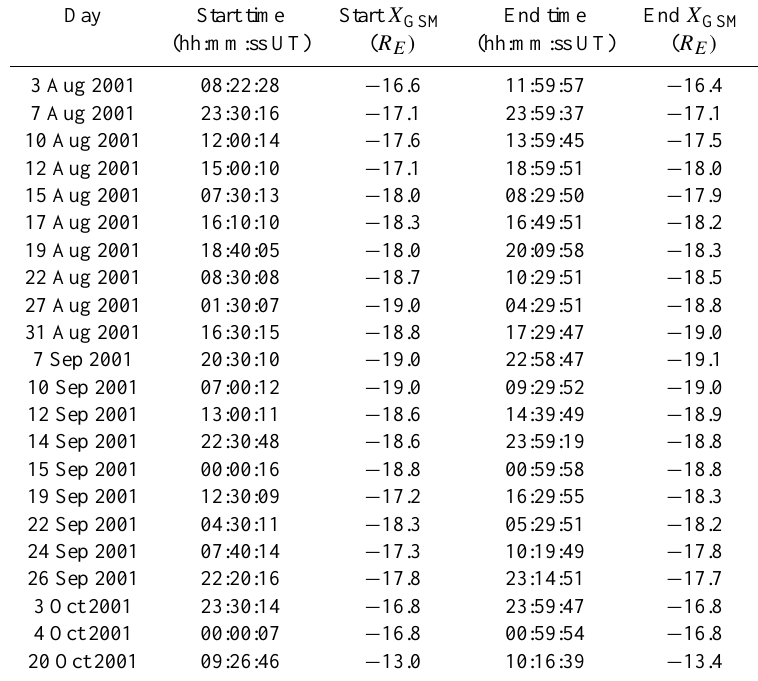
Table 1. Summary of observations.